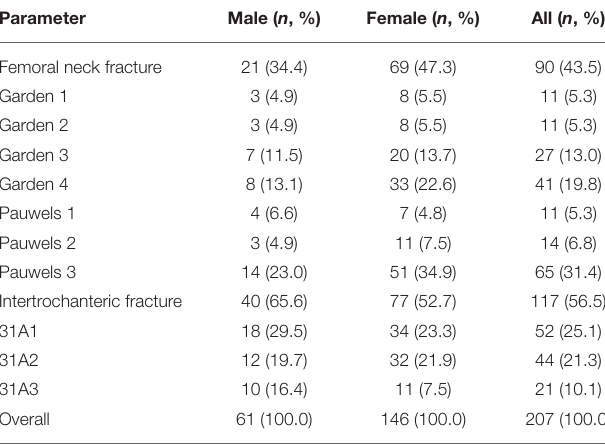
TABLE 1 | Distribution of fracture patterns of male and female patients.